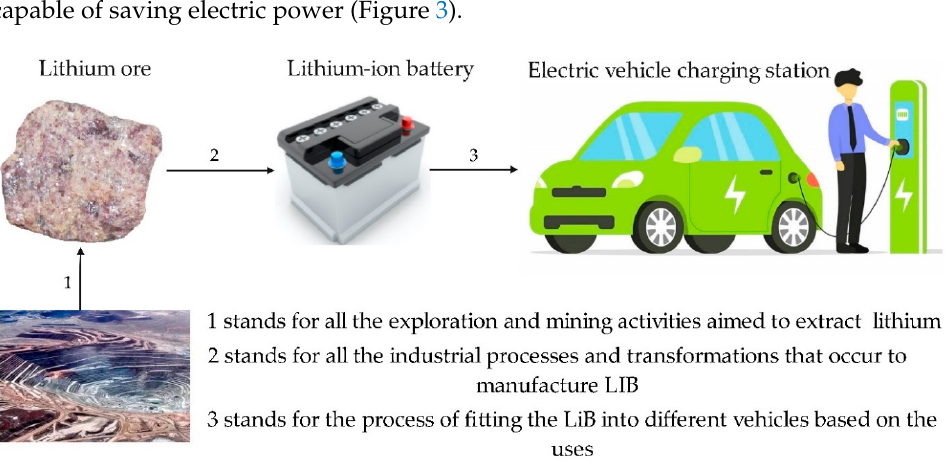
Figure 3. The simplified scenario of lithium to electric vehicles.